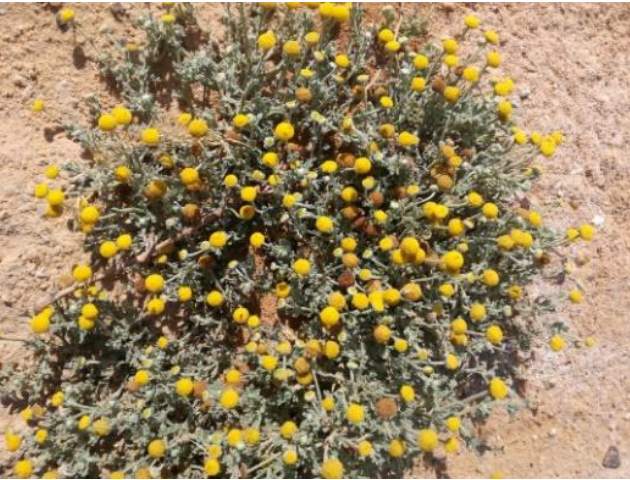
Figure 1. Photograph of C. anthemoides taken at the time of collection.